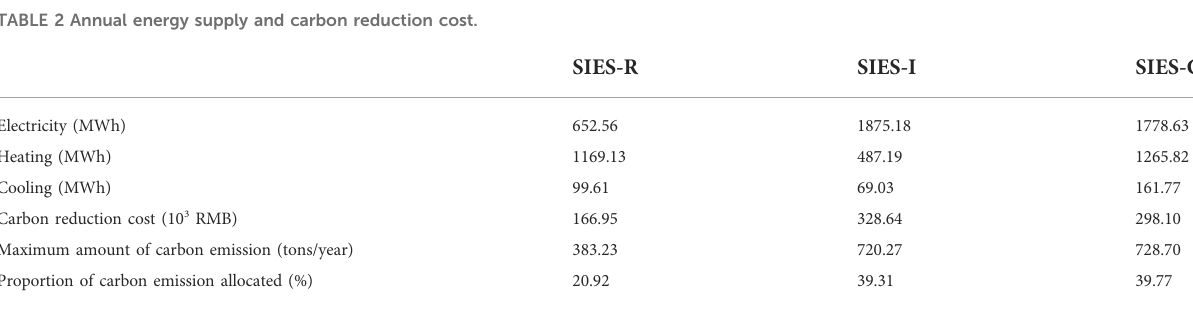
TABLE 2 Annual energy supply and carbon reduction